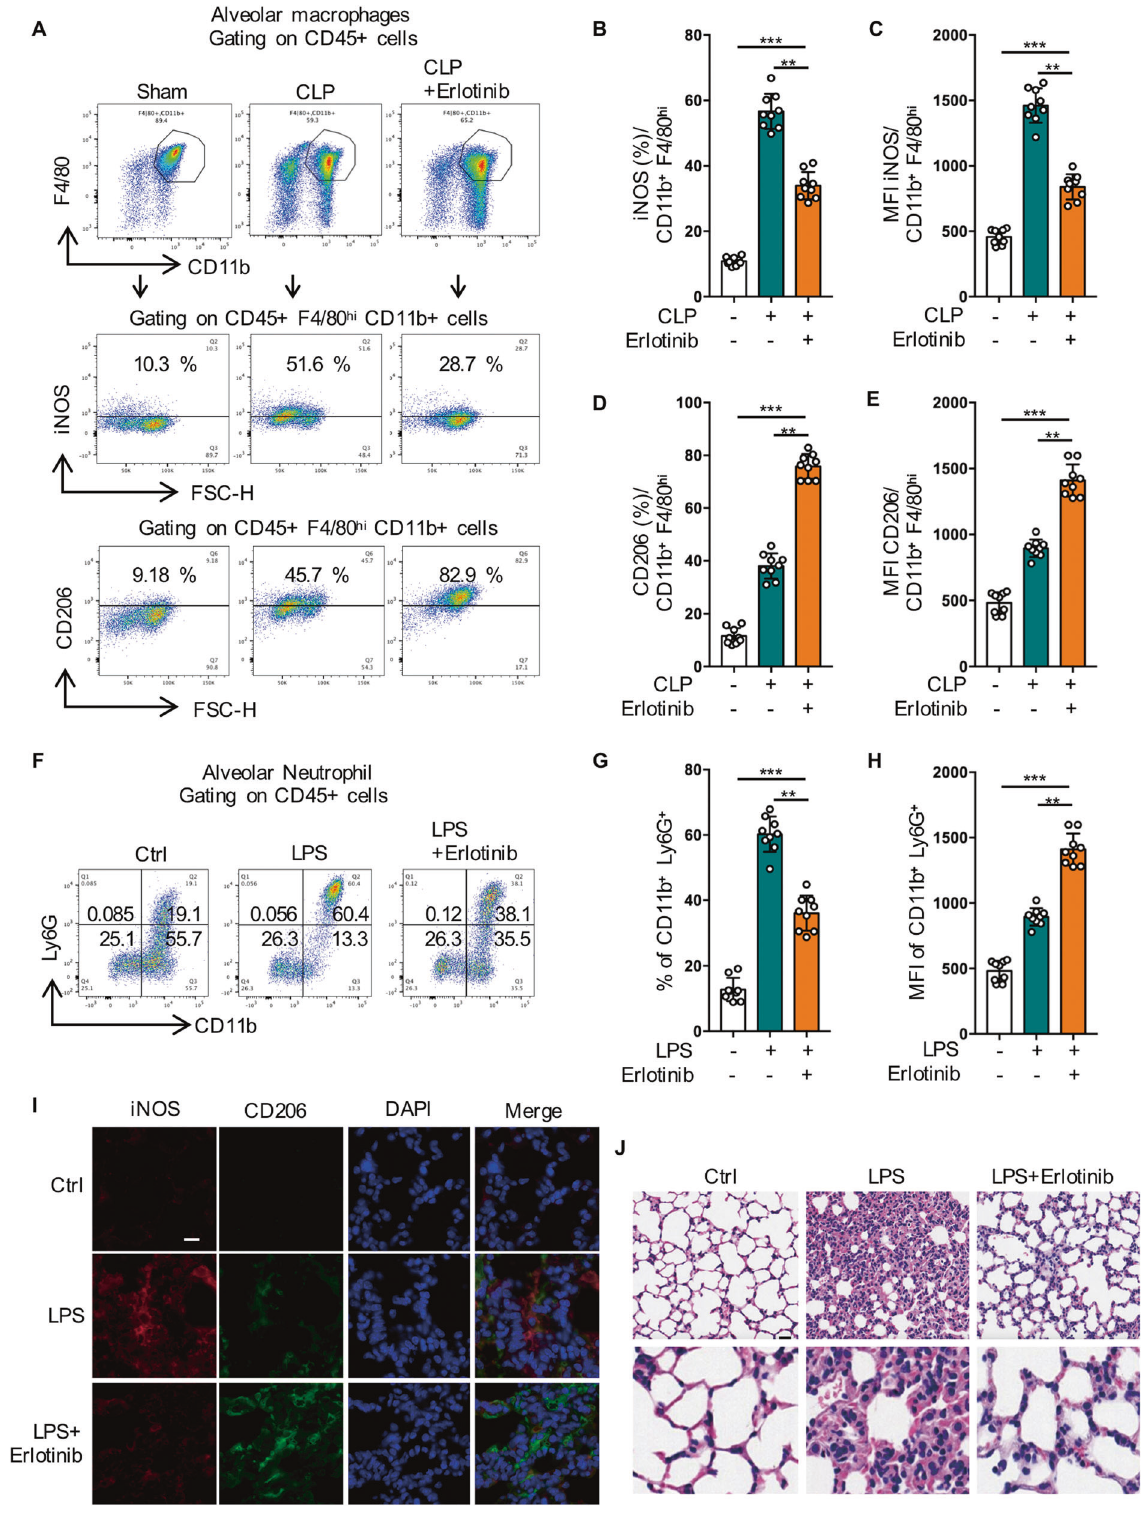
Immuno fl uorescence For cells, RAW264.7 or BMDM cells were seeded in 35 mm Glass Bottom Dish and then subjected to fi xation with 4% paraformaldehyde, and permeabilization with 0.1% TritonX-100, then incubated with the indicated primary antibody at 4 °C overnight, after blocked with 5% BSA for 30 min at RT. After incubated with fl uorescent conjugated secondary antibodies